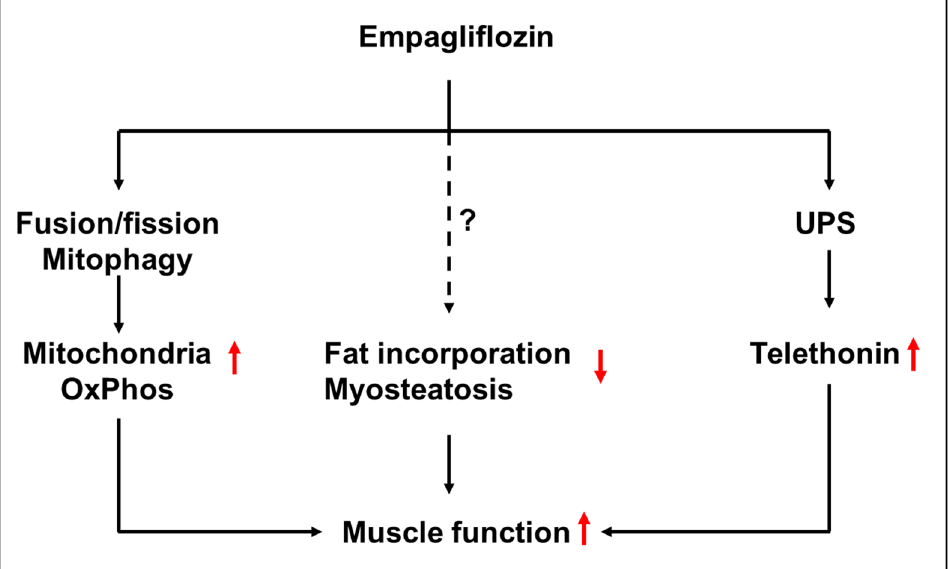
Figure 9. Hypothetical working model how Empagliflozin might improve skeletal muscle function in settings of HFpEF by the modulation of mitochondrial oxidative phosphorylation, myosteatosis and telethonin expression. UPS = ubiquitin proteasome system. ↑ , ↓ = up- or downregulated by Empa, ? and dottet line = exact pathway not defined yet.